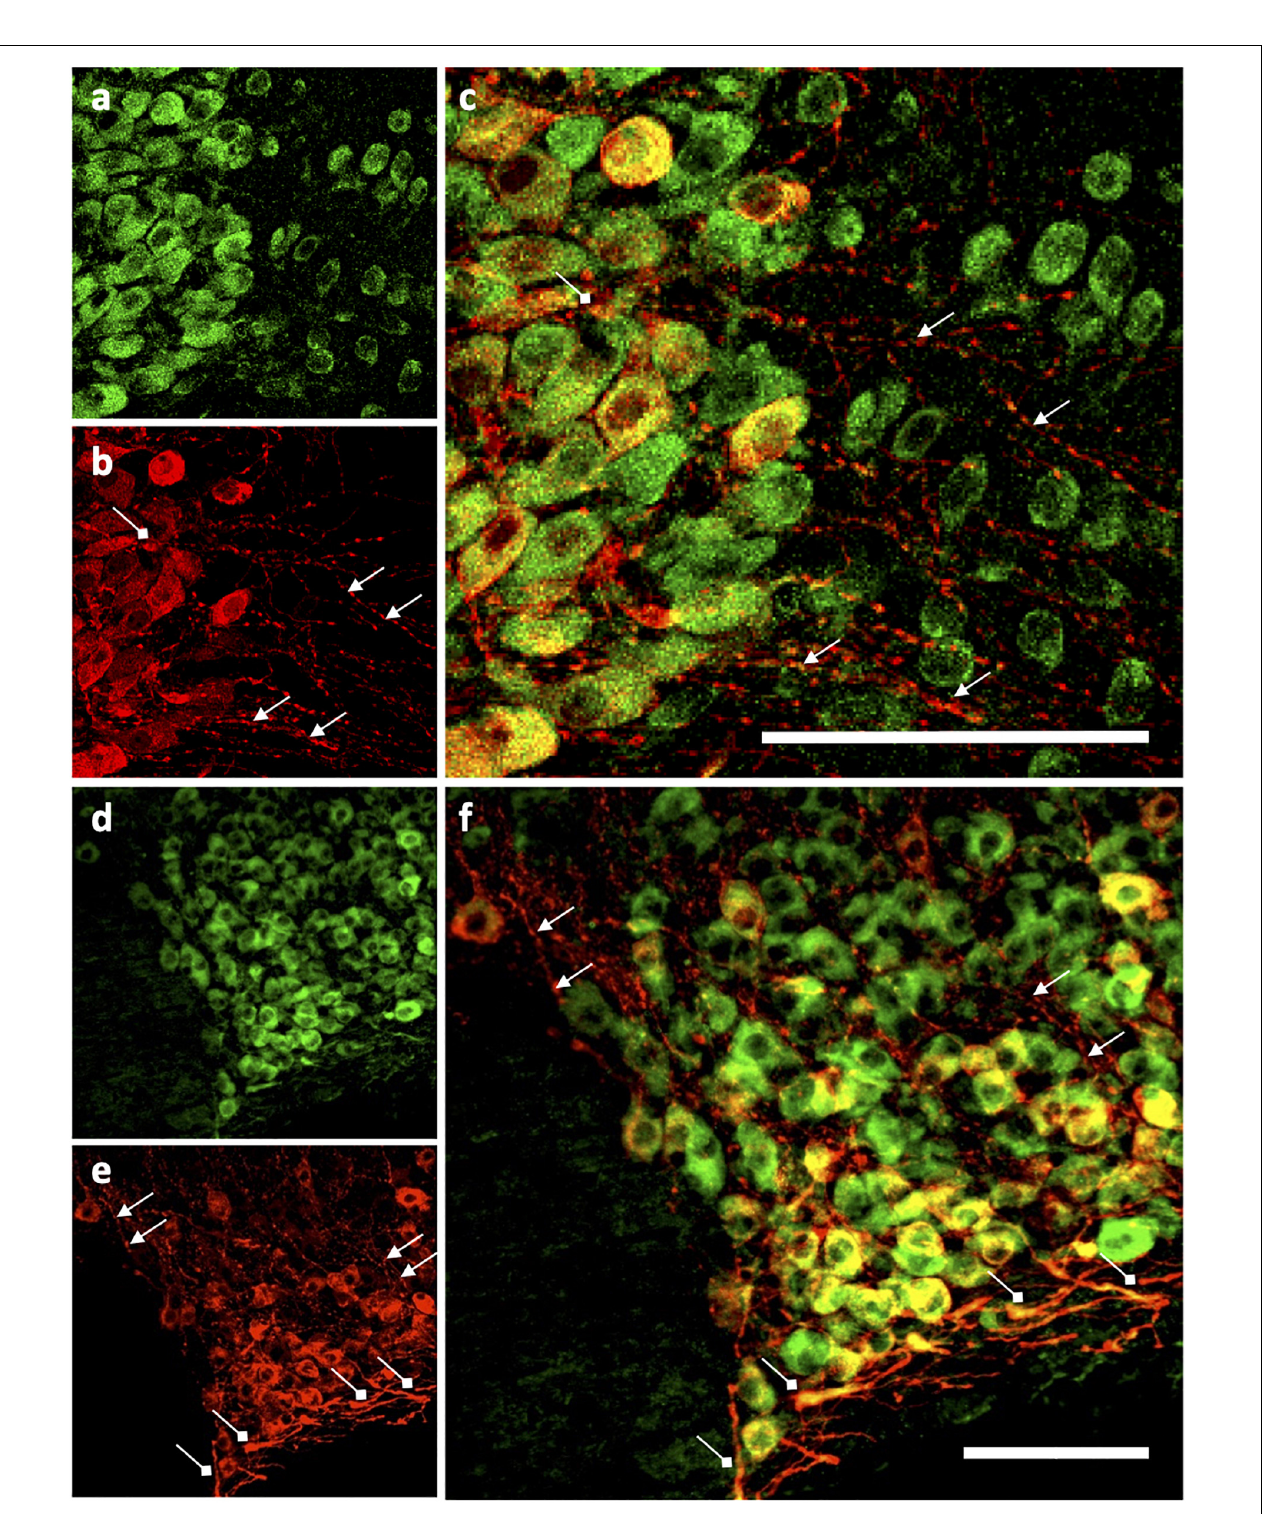
FIGURE 9 | Ucn expression in vasopressinergic cells of PVN and SON. Ucn expression was noted in both vasopressinergic magnocellular PVN (a–c) and SON (d–f) cells. Ucn expression (green) can be clearly seen within what appear to be cell bodies in both nuclei. Vasopressinergic axonal projections (selection marked with triangle-tipped arrows) showed little expression of Ucn in either PVN or SON. Ucn expression did appear to localise within dendrites (selection marked with diamond-tipped arrows) of vasopressinergic neurons however as well as vasopressinergic cell bodies in both PVN and SON. SON (a–c) as follows; (a) Ucn, (b) VP, (c) Ucn + VP. PVN (d–f) as follows; (d) Ucn, (e) VP, (f) Ucn + VP. Ucn, urocortin; VP, arginine vasopressin. Scale Bar = 100 µ m.